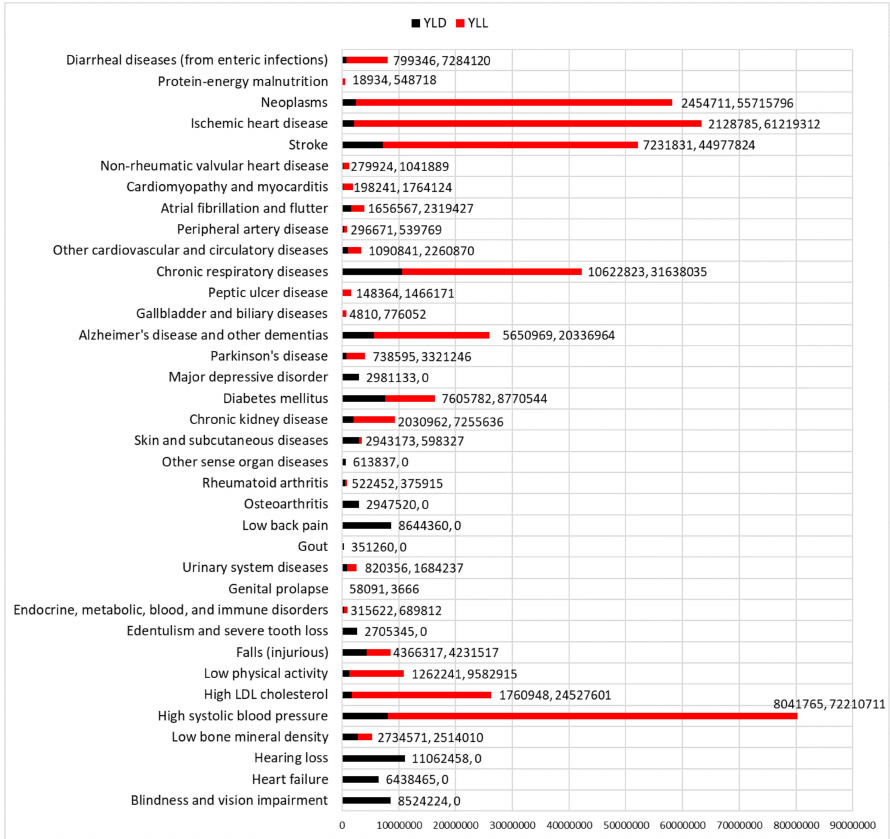
Figure 5. Absolute counts of the Years Lived with Disability (YLD) and the Years of Life Lost (YLL) from the 36 GBD-FI items for the global population aged ≥ 70 years in 2017. The sum of YLD and YLL is Disability-Adjusted Life years